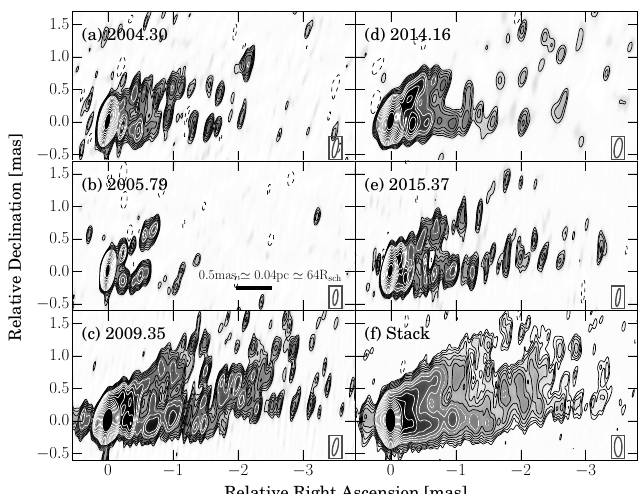
Figure 1. The preliminary 3 mm Very Long Baseline Interferometry (VLBI) images of M87 ordered in time. The beam is shown at the bottom right corner and the observing date is shown at the top left corner in decimal year format. The contours and grey color show the total intensities. Except panel (f), the lowest contour level corresponds to 1 mJy/beam and the contours increase by a factor of √ 2. For panel (f) the lowest level is 0.4